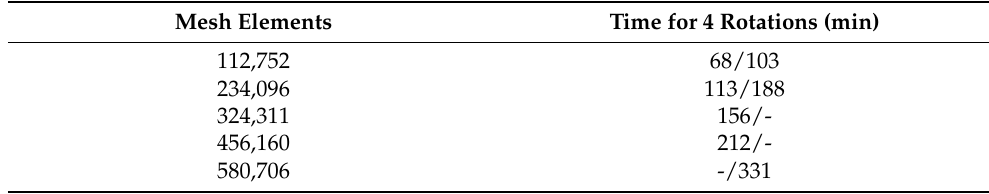
Table 3. Mesh analysis simulation times (personal desktop/virtual desktop).